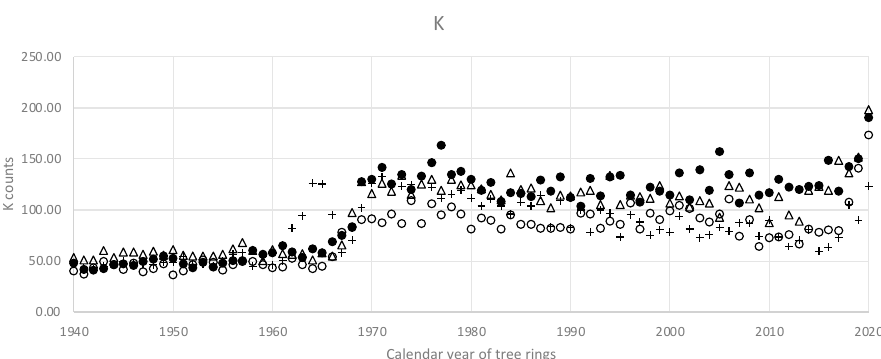
Figure 7. An example macrotrend in K counts across the tree rings facing the cardinal directions in pine #1. Legend: east ( • ), west (O), north ( ∆ ), south (+).